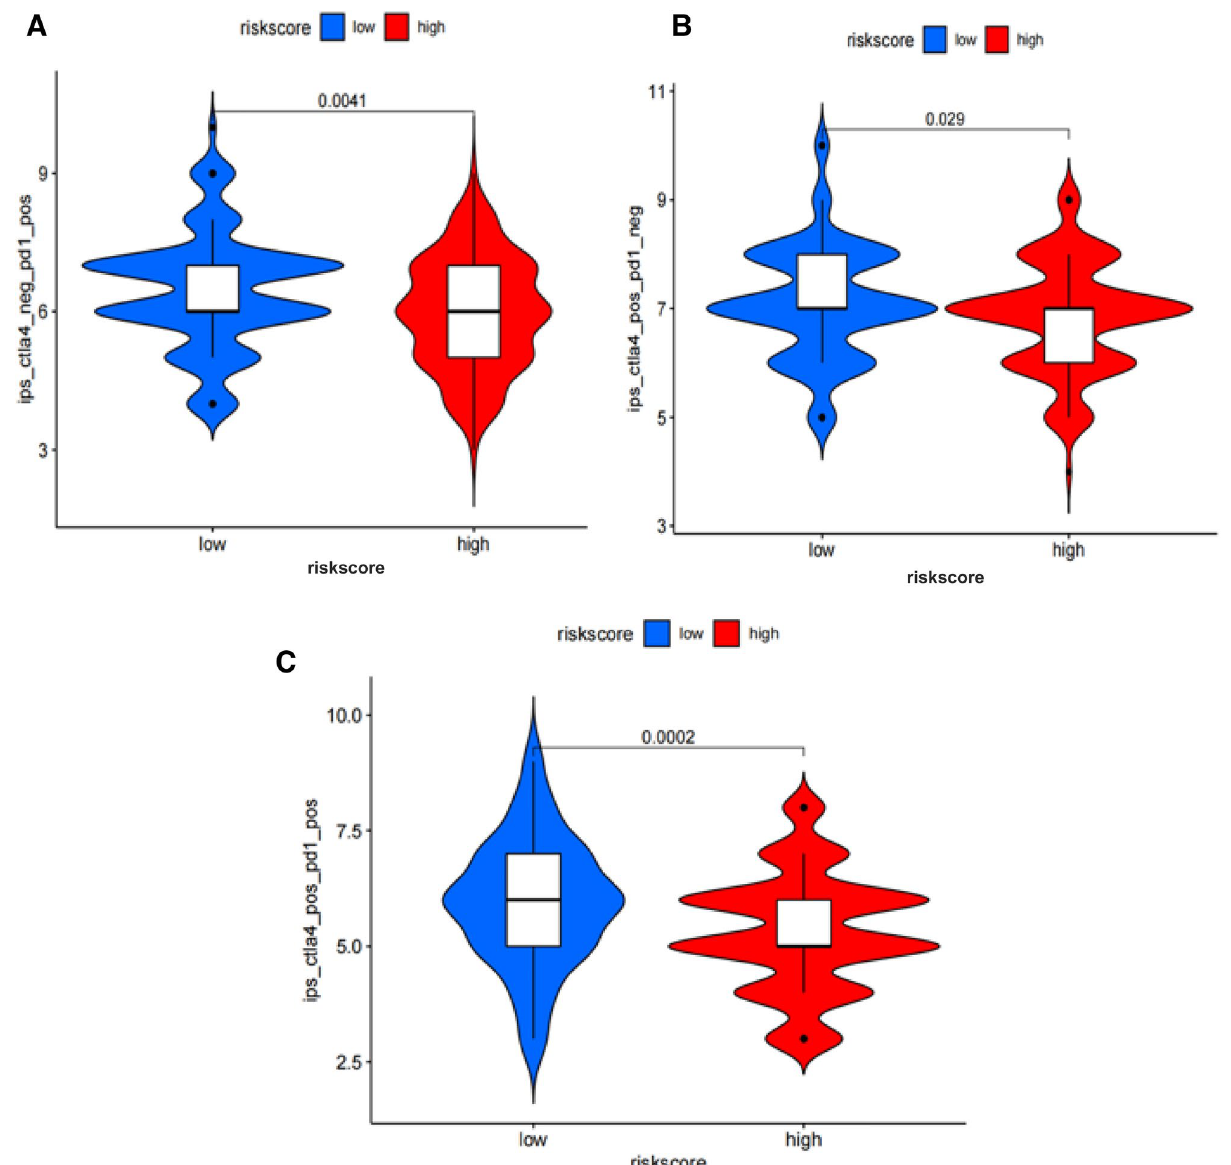
Figure 7. Violin diagram was used to visualize the different treatments (CTLA-4) response between low- and high- risk patients. The patients in low-risk group had good response to the single ( A , B ) and combined ( C ) use of the two